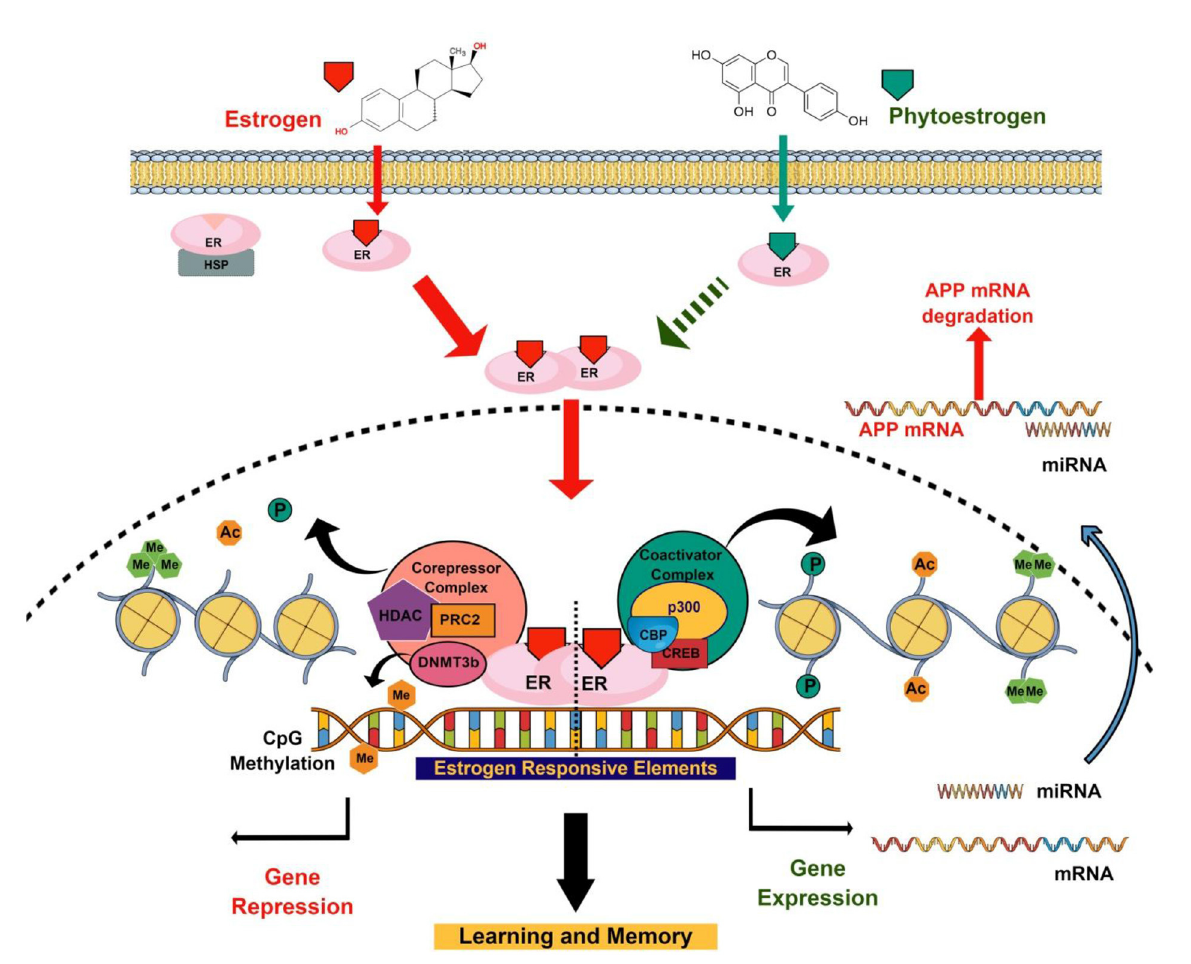
FIGURE1 Schematic diagram representing neuromodulating roles of E2 and phytoestrogens through epigenetic modifications. E2–ER complex recruits co-regulators at the ERE of the genes involved in learning and memory. Co-regulators may be co-activator that induced gene expression and co-repressor that induced gene repression. These co-regulators regulate gene expression that involves learning and memory through epigenetic modifications (DNA methylation, histone PTMs, and miRNA). Similar to E2, the memory-enhancing properties of phytoestrogen may involve epigenetic modifications by recruiting coregulators at the promoter of synaptic plasticity